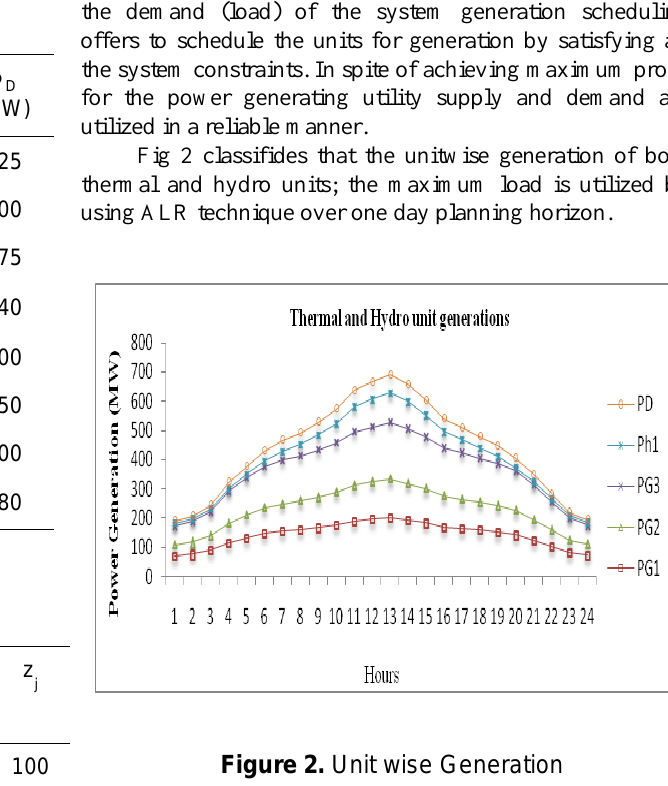
Table 2. Load demand